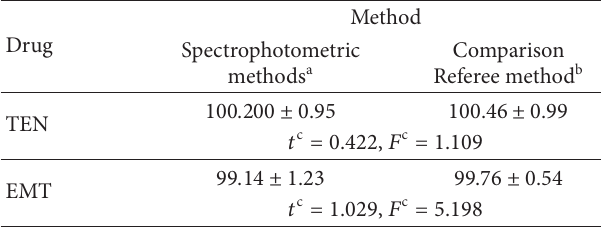
Table 4: Application of the proposed methods to analysis of TEN and EMT in Truvada